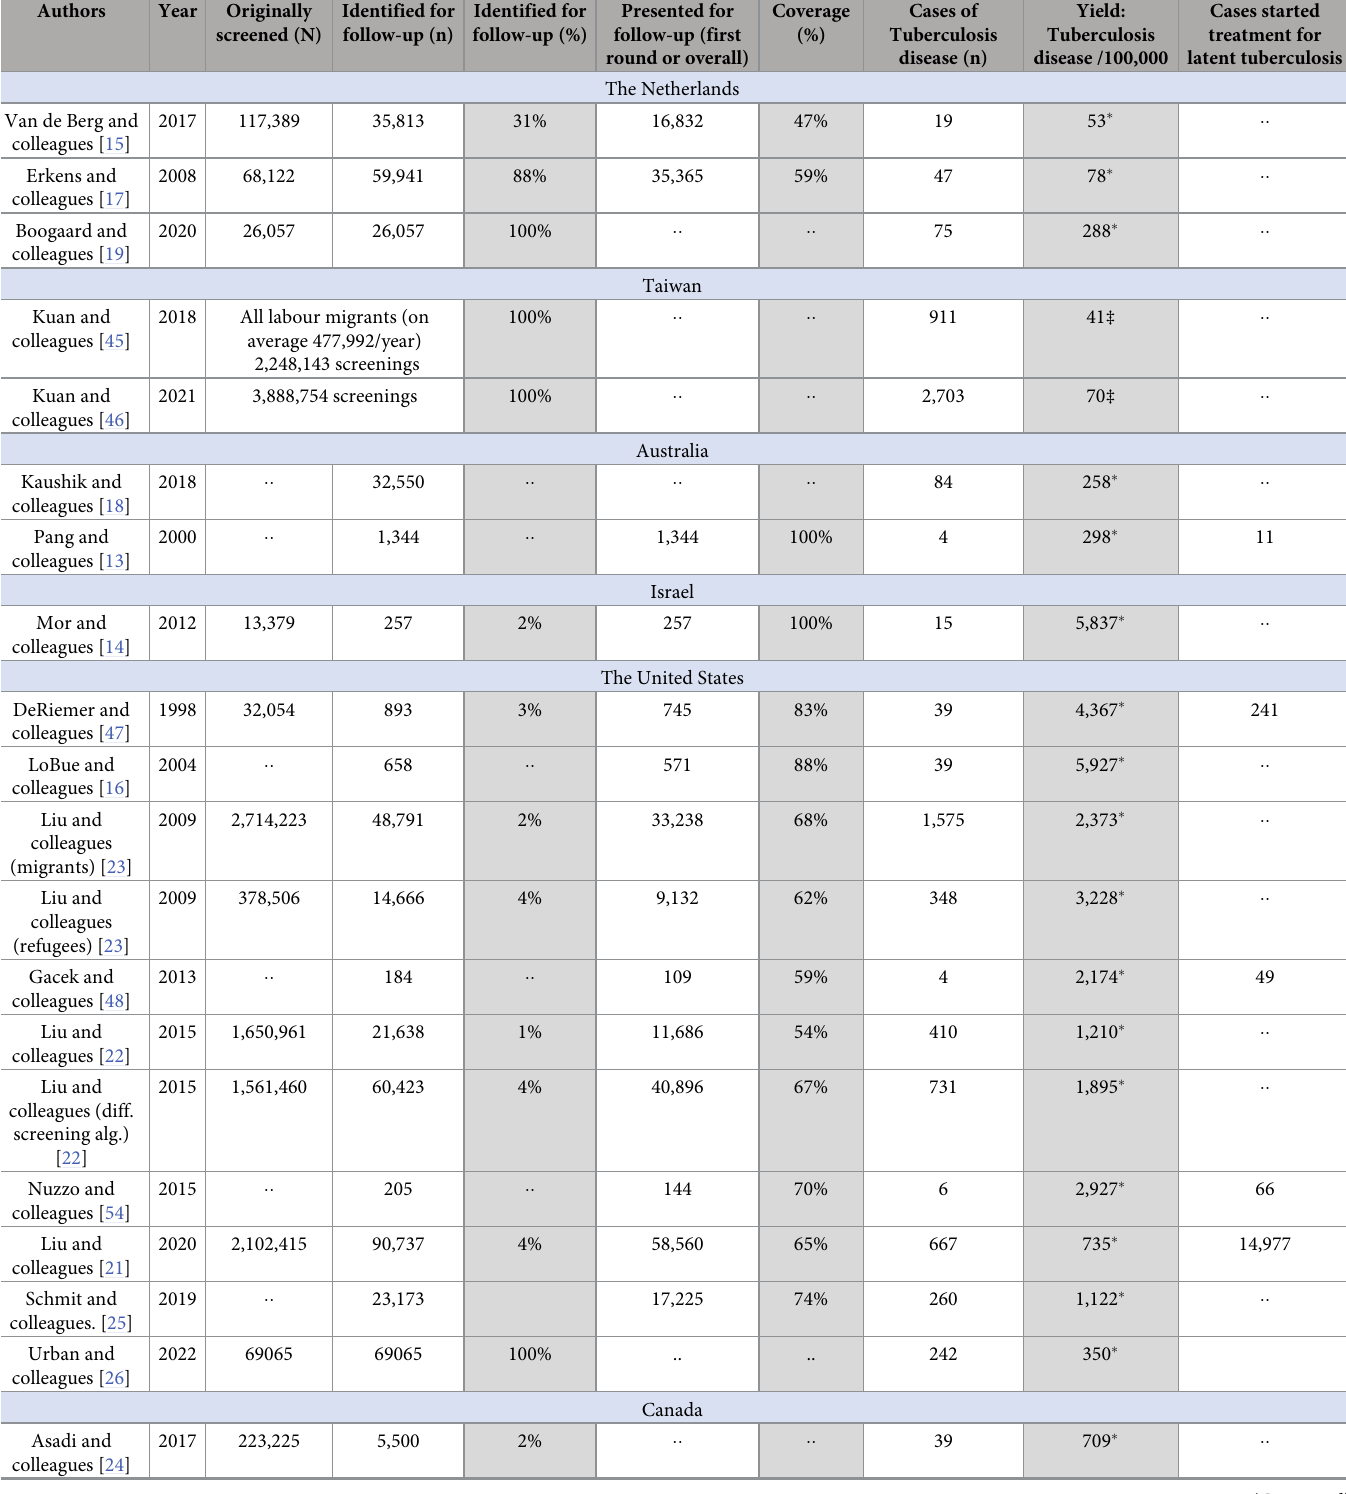
Table 2. Summary of reviewed studies and outcome